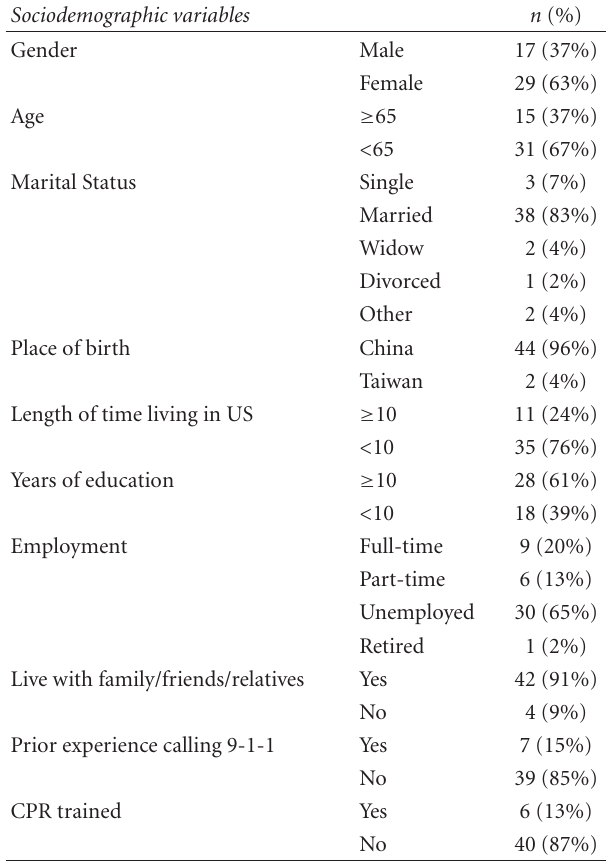
Table 2: Study population characteristics ( n =